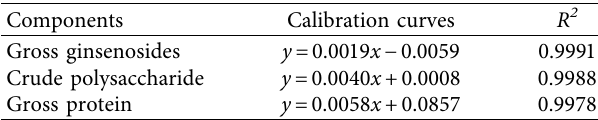
Table 1: Te correlation coefcients between gross ginsenosides, crude polysaccharide, and gross protein contents of ginseng fowers